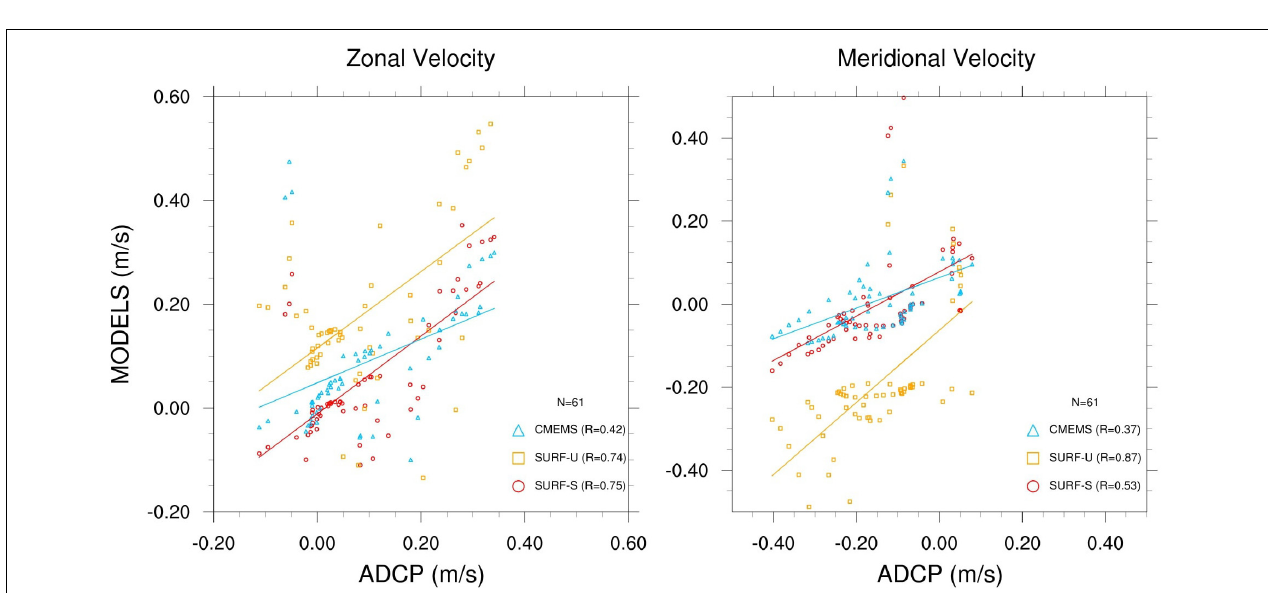
FIGURE 11 | Averaged daily surface velocity fields on 4 December, 1995 of the parent CMEMS model ( left panel ), the structured ( central panel ), and unstructured ( right panel ) grid SURF model.